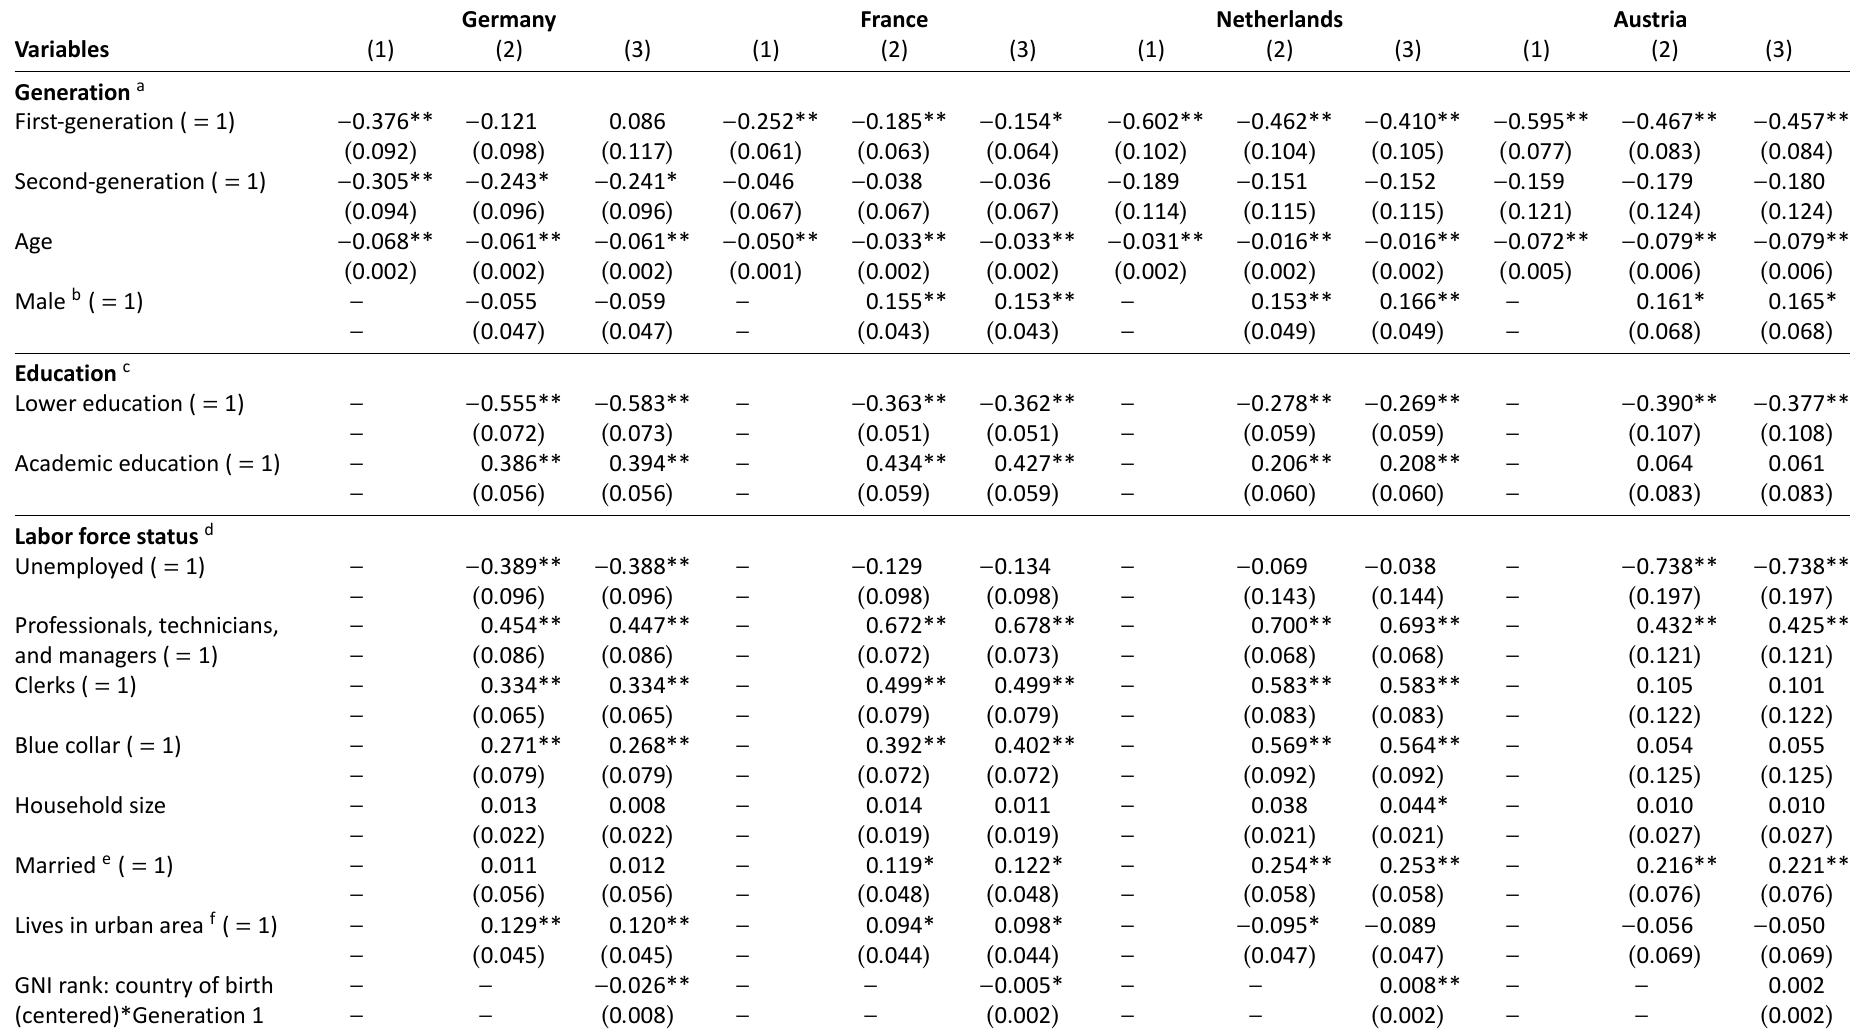
Table 2. Ordered regression predicting good general health status by country of destination (dependent variable is self-perceived health , 1–3, 3 = very good